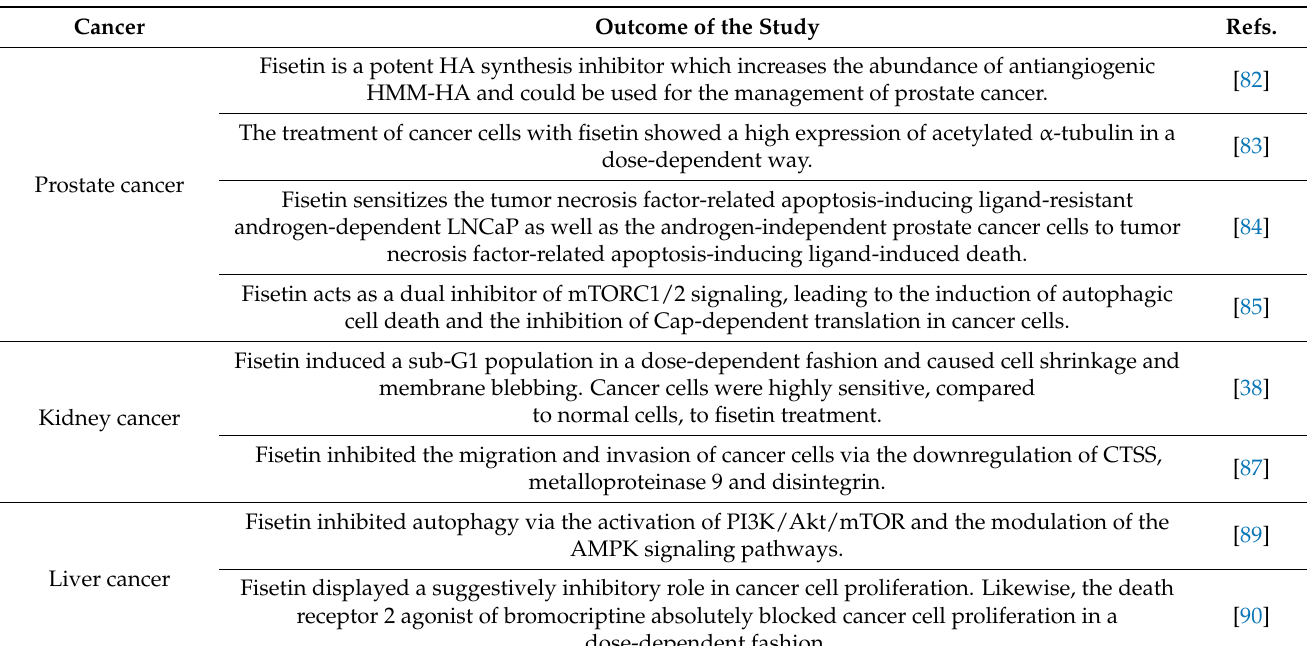
Table 2. Anticancer effects of fisetin in different types of